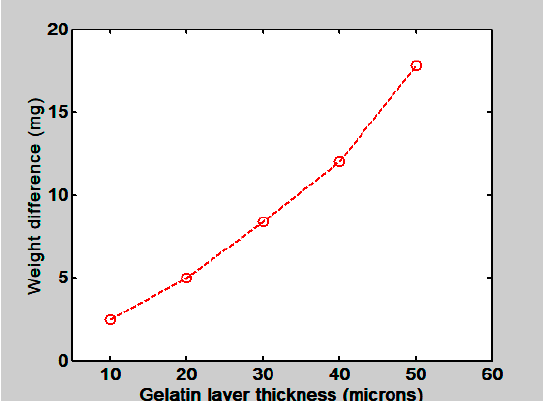
Figure 3. Plot shows the weight difference (mg) between the values when the films were dry and after they had absorbed water molecules from the atmosphere as a function of the film’s thickness (µm).